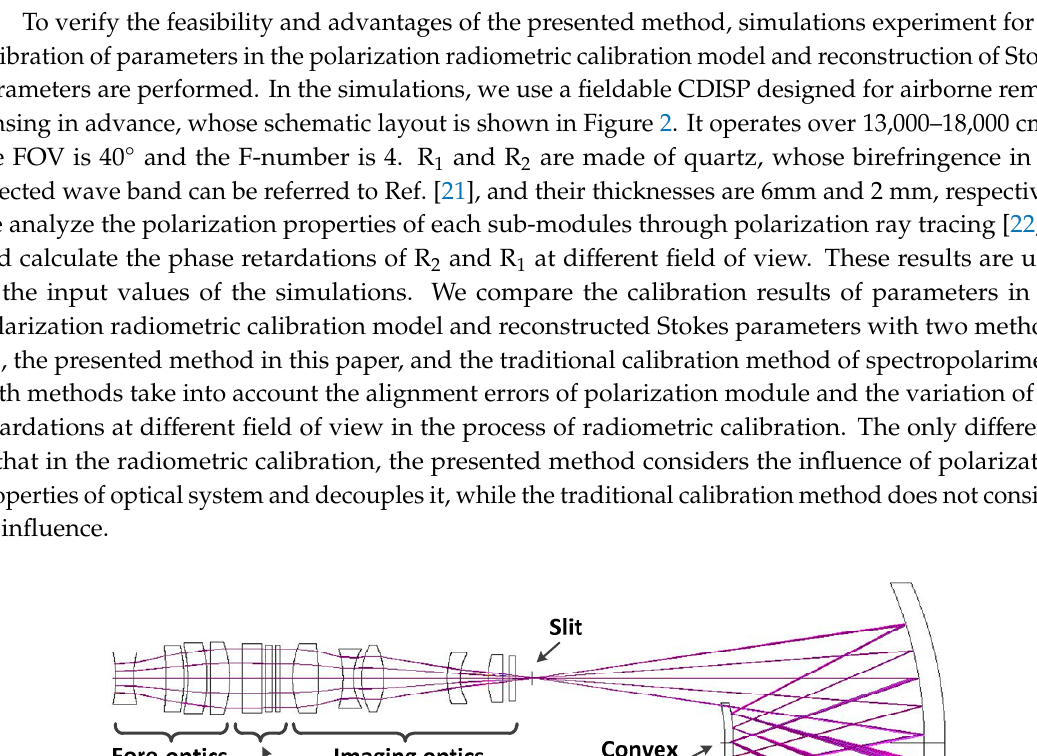
Figure 3. Quantum Efficiency curve of the detector.